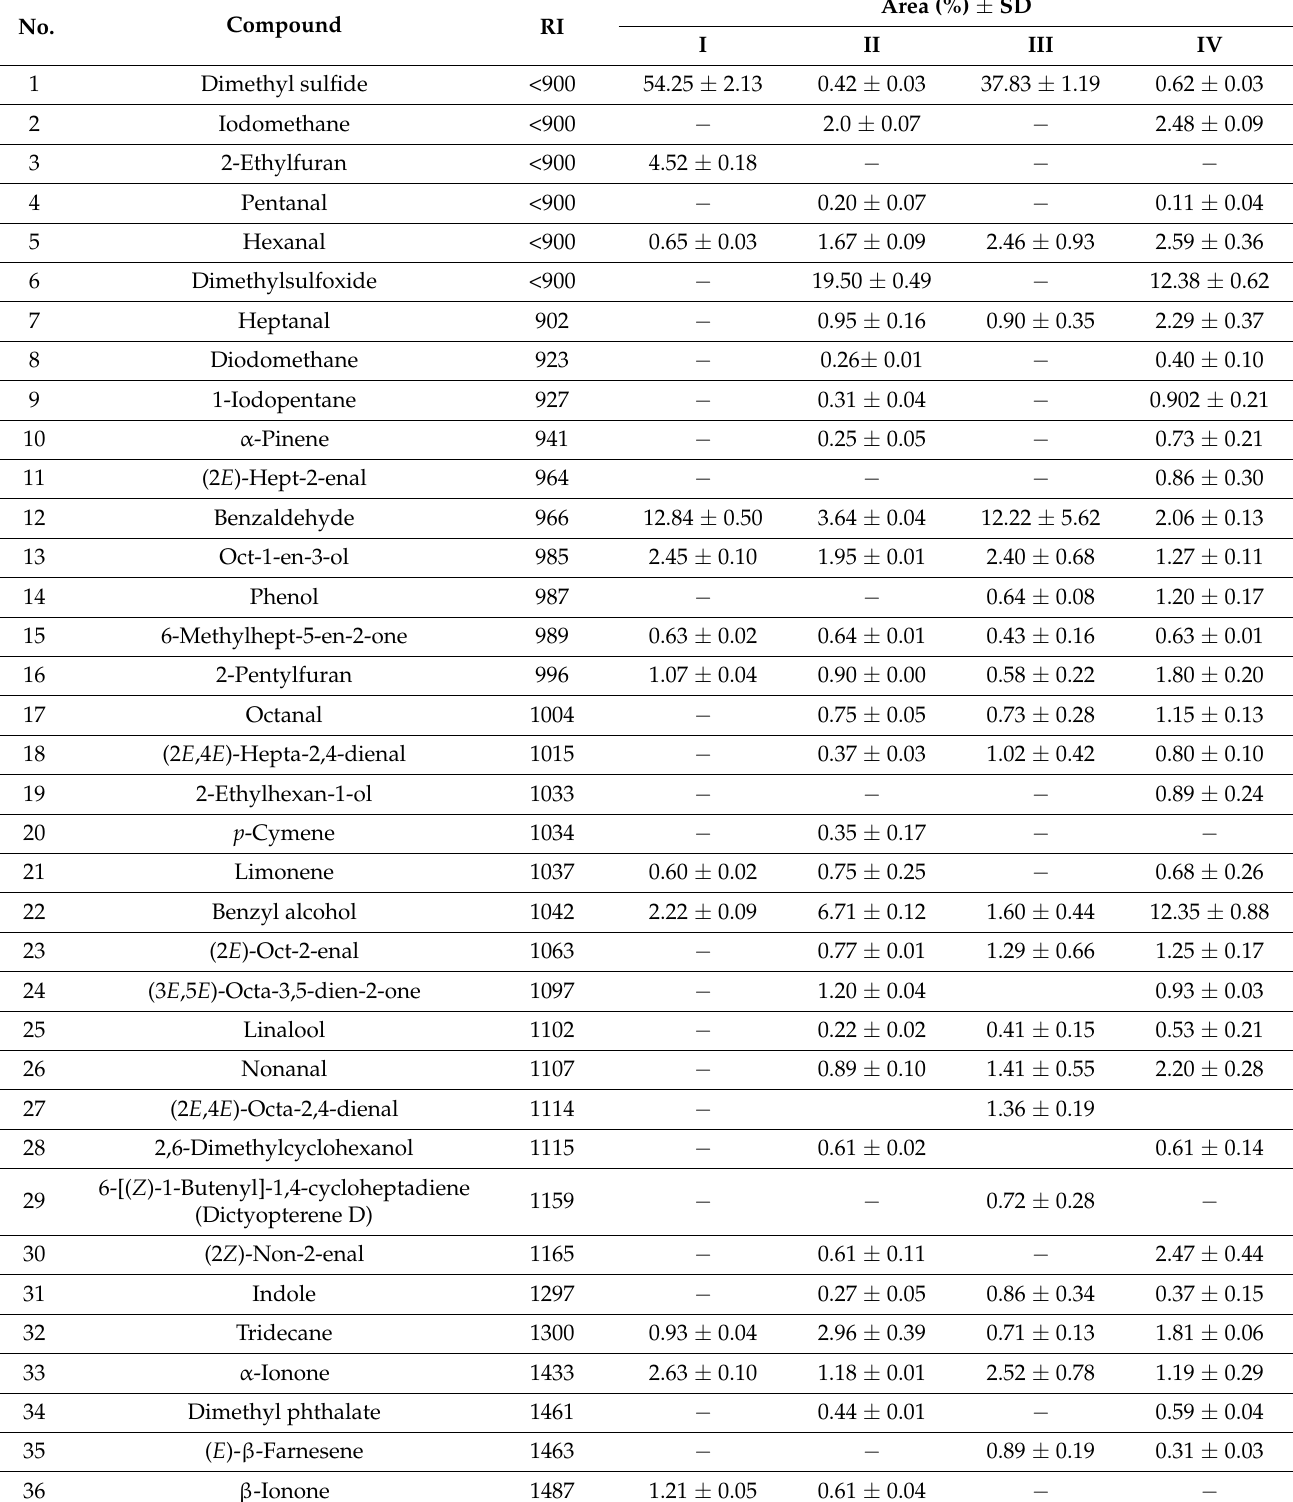
Table 1. The volatile compounds from Codium adhaerens isolated by headspace solid-phase microextraction (HS-SPME) and analysed by gas chromatography–mass spectrometry (GC-MS): (I—fresh C. adhaerens extracted by DVB/CAR/PDMS fibre, II—air-dried C. adhaerens extracted by DVB/CAR/PDMS fibre, III—fresh C. adhaerens extracted by PDMS/DVB fibre, IV—air-dried C. adhaerens extracted by PDMS/DVB